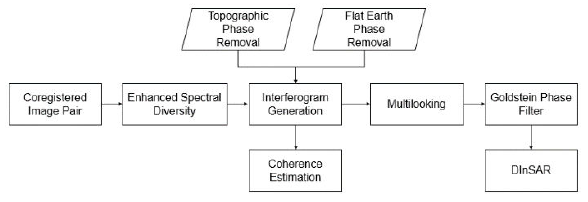
Figure 4. DInSAR Processing